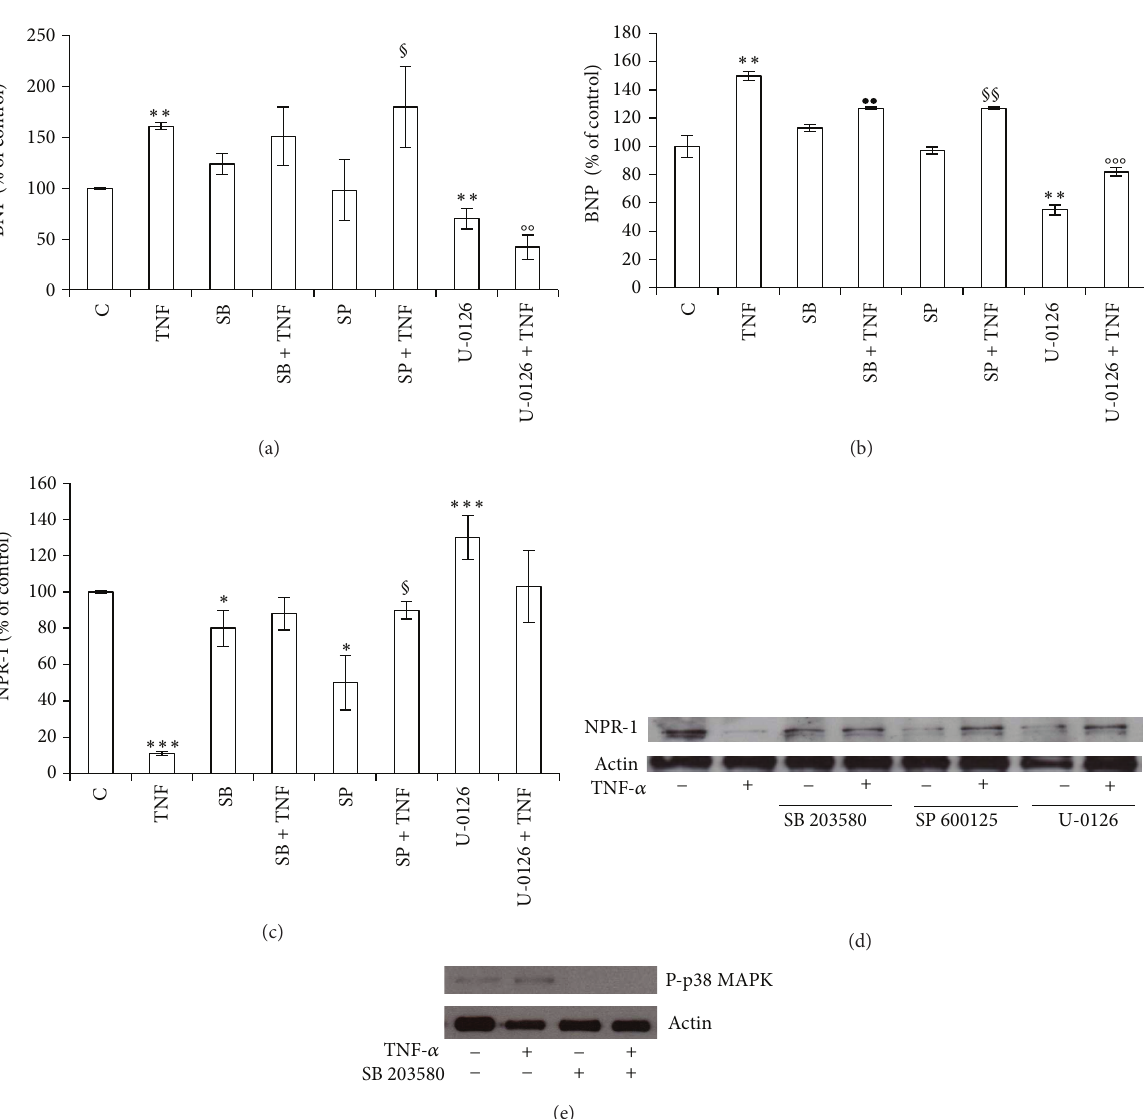
Figure 5: TNF- 𝛼 modulation of BNP and NPR-1 expression may require activation of MAPKs pathway. BEAS-2B cells were treated with 10ng/mL TNF- 𝛼 alone or in combination with 10 𝜇 M SB 203580 (p38 MAPK inhibitor), SP 600125 (JNK 1/2 inhibitor), or U-0126 (ERK 1/2 inhibitor), for 24 h. Panels show: ((a), (b)) BNP, ((c), (d)) NPR-1 gene expression at mRNA ((a), (c)) and protein ((b), (d)) level, and (e) Phospho-p38 MAPK protein level. Western blots were obtained by using the specific rabbit polyclonal or monoclonal Abs. The blots were stripped of the bound Ab and reprobed with mouse anti- 𝛽 -actin, to confirm equal loading. Western blots are representative of three separate experiments. All histograms indicate means ± SD of three different cultures each one tested in quadruplicate and expressed as percentage of control. ( ∗ 𝑃 < 0.05 , ∗∗ 𝑃 < 0.01 , and ∗∗∗ 𝑃 < 0.001 versus Controls) ( ∙∙ 𝑃 < 0.01 versus SB) ( § 𝑃 < 0.05 , §§ 𝑃 < 0.01 versus SP) ( ∘∘ 𝑃 < 0.01 , ∘∘∘ 𝑃 < 0.001 versus U-0126). C: Controls (untreated